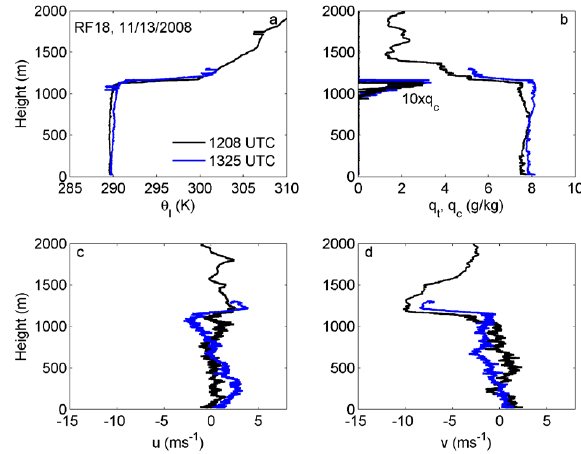
Fig. 1. Soundings taken near 72°W and 20°S during Twin-Otter RF18, 13 November 2008. (a) Liquid water potential temperature ( θ l ) ; (b) total water mixing ratio ( q t ) and cloud water mixing ratio ( q c ) ; (c) u ; and (d) v . Following definitions are applied for the thermodynamic variables: θ l = θ − Lθ/(T c p ) · q c and q t = q v + q c , where θ is potential temperature and q v water vapor mixing